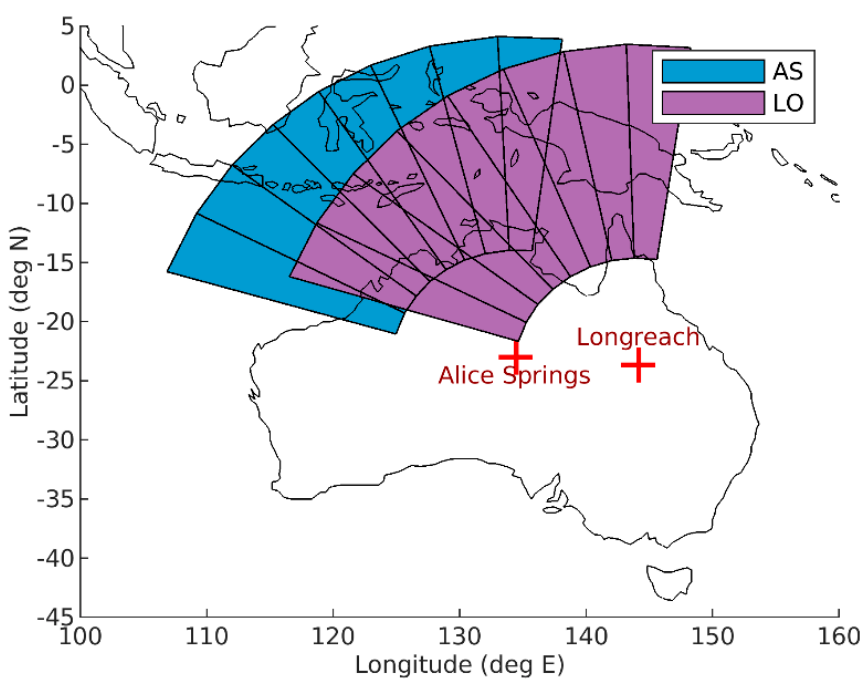
Figure 3. Backscatter sounder locations, fields of view and disposition of the eight receive beams. The inner and outer arcs are 1000 and 3000 km from the sounders, respectively.